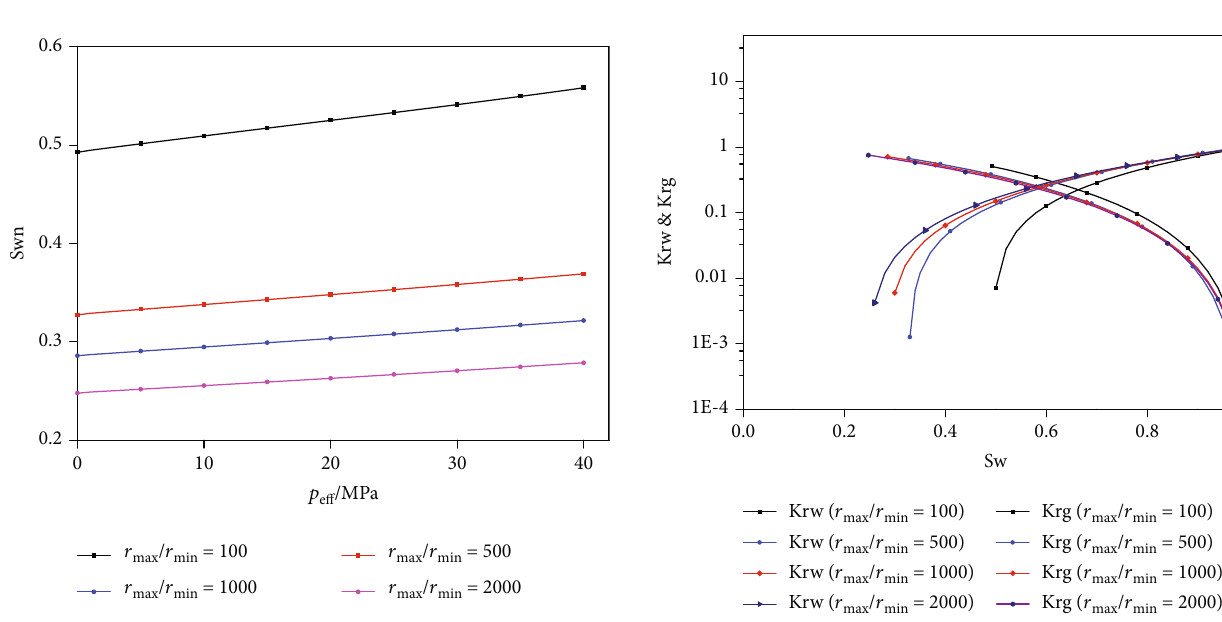
Figure 10: Curves of relative permeability under di ff erent ratios of the maximum pore radius to the minimum pore